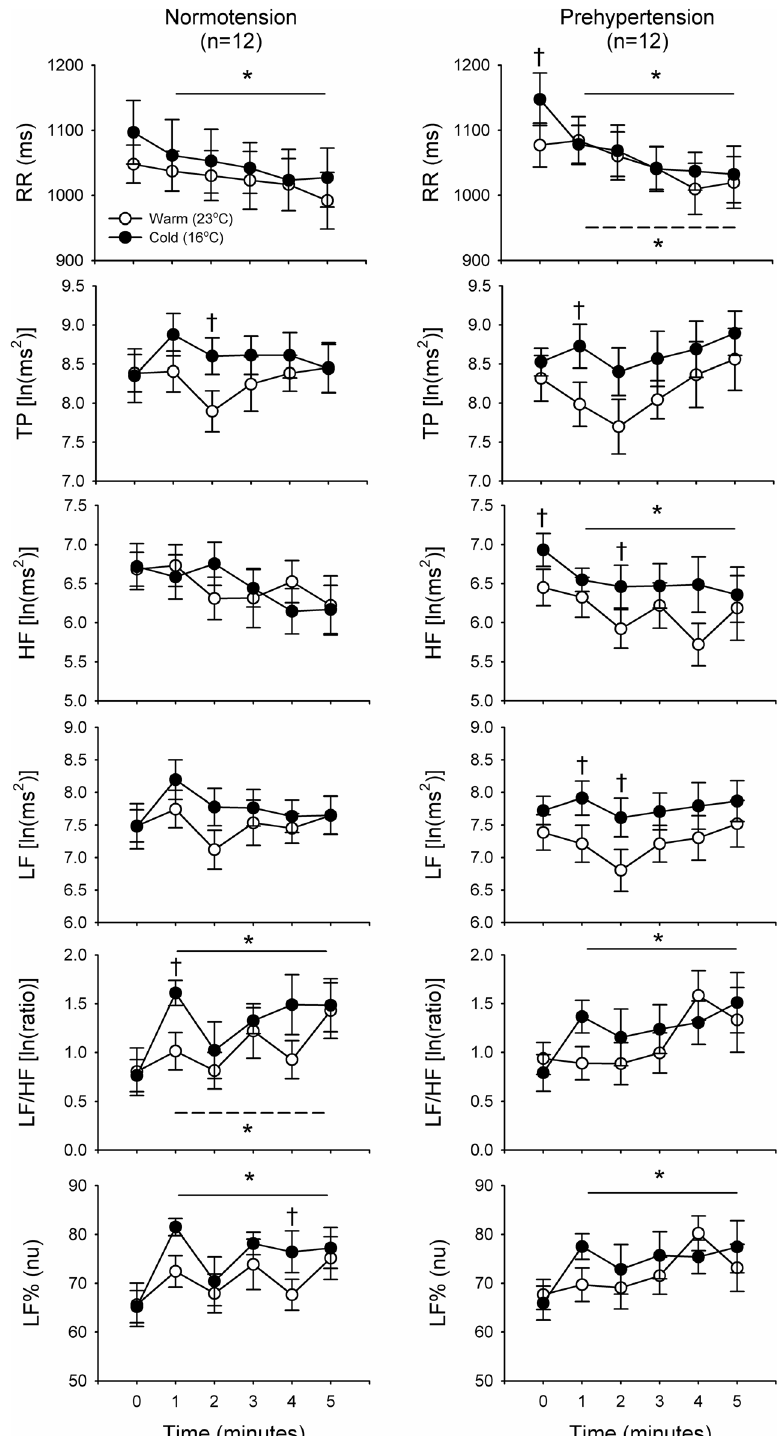
Fig 4. Time course of variation of the heart rate variability (HRV) parameters after the final sleep stage transition from NREM to REM sleep. All dots represent the average absolute values. Dots for point 0 on the X axis represent the average absolute values 5 minutes before the sleep transition, whereas points 1 to 5 represent the average absolute values at 1-minute intervals after the sleep transition. Average values (solid and dashed lines represent the average range) represent the changes after the sleep transition from